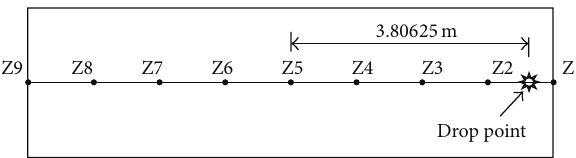
Figure 2: The position of the measured points in the drop